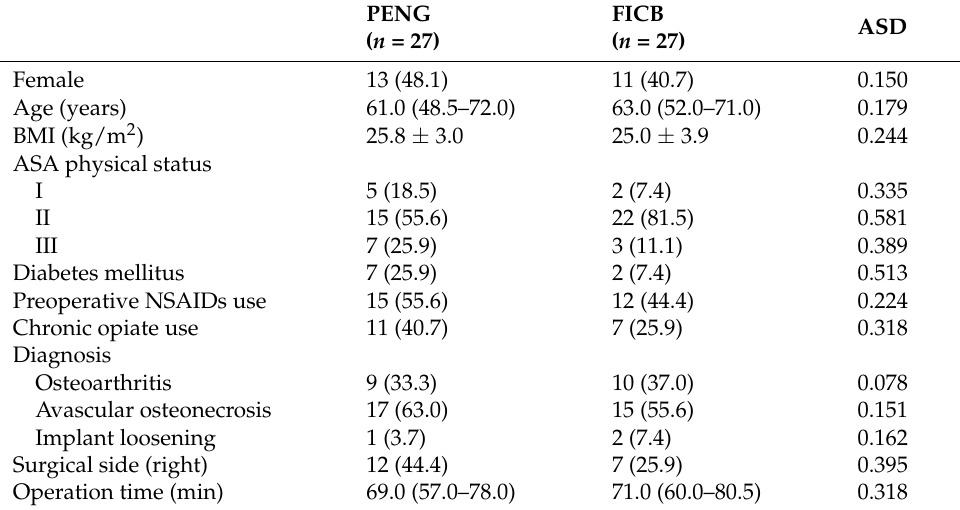
Figure 2. Flow diagram of patient selection: ASA, American Society of Anesthesiologists; FICB, supra-inguinal fascia iliaca compartment block; PCA, patient-controlled analgesia; PENG, pericapsular nerve group block. Table 1. Patient and operation characteristics.